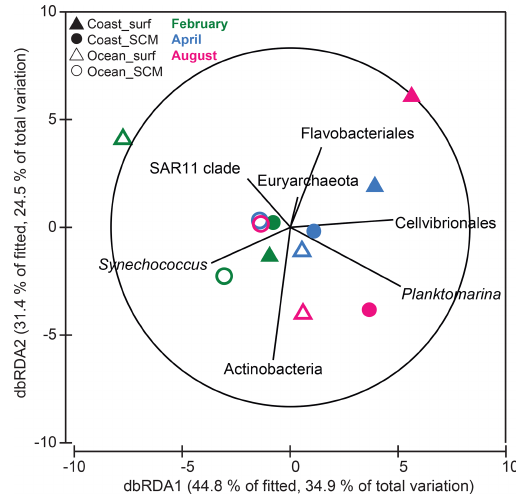
Figure 8. Distance-based redundancy analysis (dbRDA) of B- vitamin responses by phytoplankton and prokaryotes based on Bray–Curtis similarity. Only prokaryotic taxa that explained vari- ability in the B-vitamin response structure selected in the DistLM model (step-wise procedure with adjusted R 2 criterion) were fit- ted to the ordination. Filled and open symbols represent samples from coastal and oceanic stations, respectively; triangles and circles represent samples from the surface and SCM, respectively; and col- ors correspond to the months of (green) February, (blue) April and (pink) August. SCM: subsurface chlorophyll